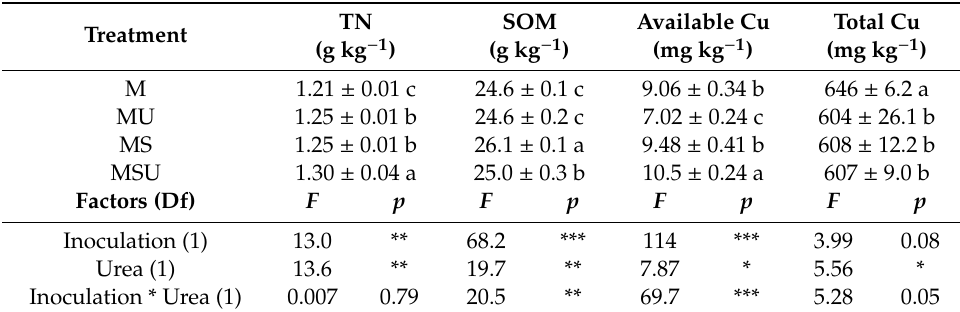
Table 2. The soil properties after the